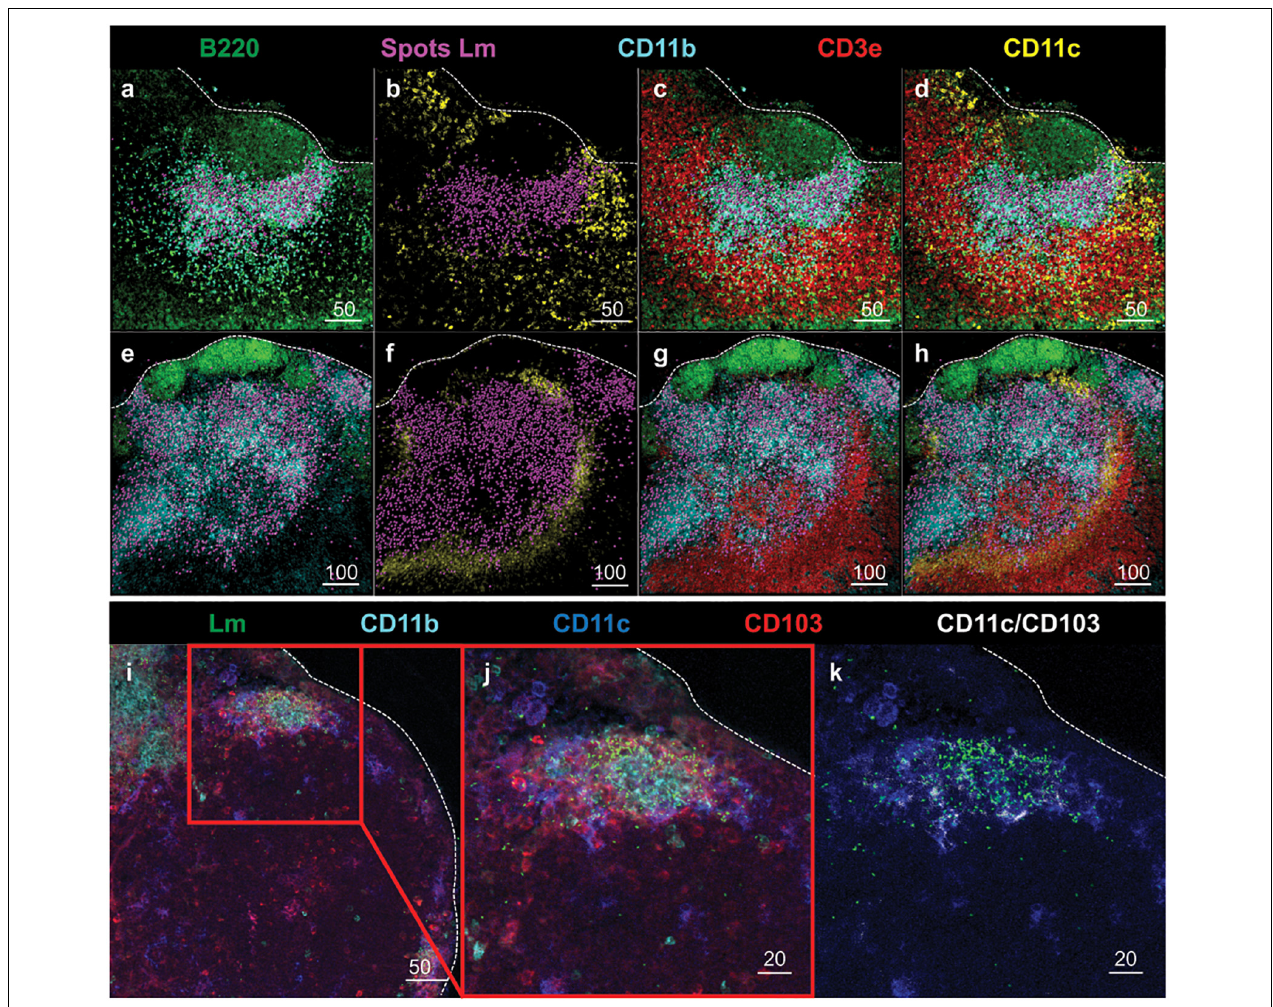
FIGURE 3 | DC subsets surround regions of InlA M Lm foci in the MLN after foodborne infection. (a–h) MLN from 2 Balb/c mice were harvested 2 days after foodborne InlA M Lm infection. MLN cryosections were stained to identify B220 (green), InlA M Lm (magenta), CD11b (cyan), CD3e (red) and CD11c (yellow). Lm staining was highlighted with magenta spheres using Imaris software. Scale bar represents 50 µ m (a–d) and 100 µ m (e–h) . (i–k) MLN from 2 Balb/c mice were harvested 3 days after foodborne InlA M Lm infection. MLN cryosections were stained to identify InlA M Lm (green), CD11b (cyan), CD11c (blue) and CD103 (red). Colocalization of CD11c and CD103 (CD11c/CD103) was highlighted in white using Imaris software. Scale bar represents 50 µ m (i) and 20 µ m (j,k) . All images are representative of at least three independent experiments, with 7–8 images taken for each timepoint.